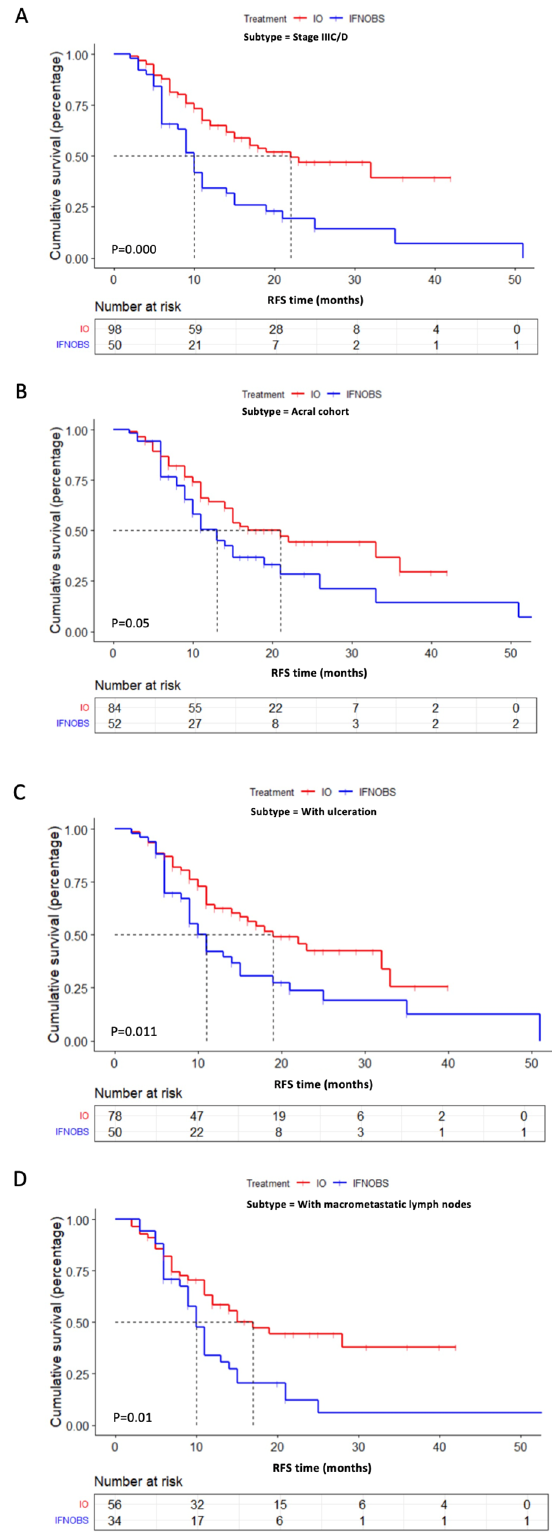
Figure 5. Kaplan–Meier curves of RFS for subgroups of acral and cutaneous patients stratified by adjuvant PD-1 inhibitor treatment versus conventional treatment (IFN+OBS). ( A ) RFS for all stage IIIC and IIID melanoma patients ( p = 0.000). ( B ) RFS for all acral melanoma patients ( p = 0.05). ( C ) RFS for all enrolled patients with ulceration ( p = 0.011). ( D ) RFS for all melanoma patients with macrometastatic lymph nodes ( p = 0.01).